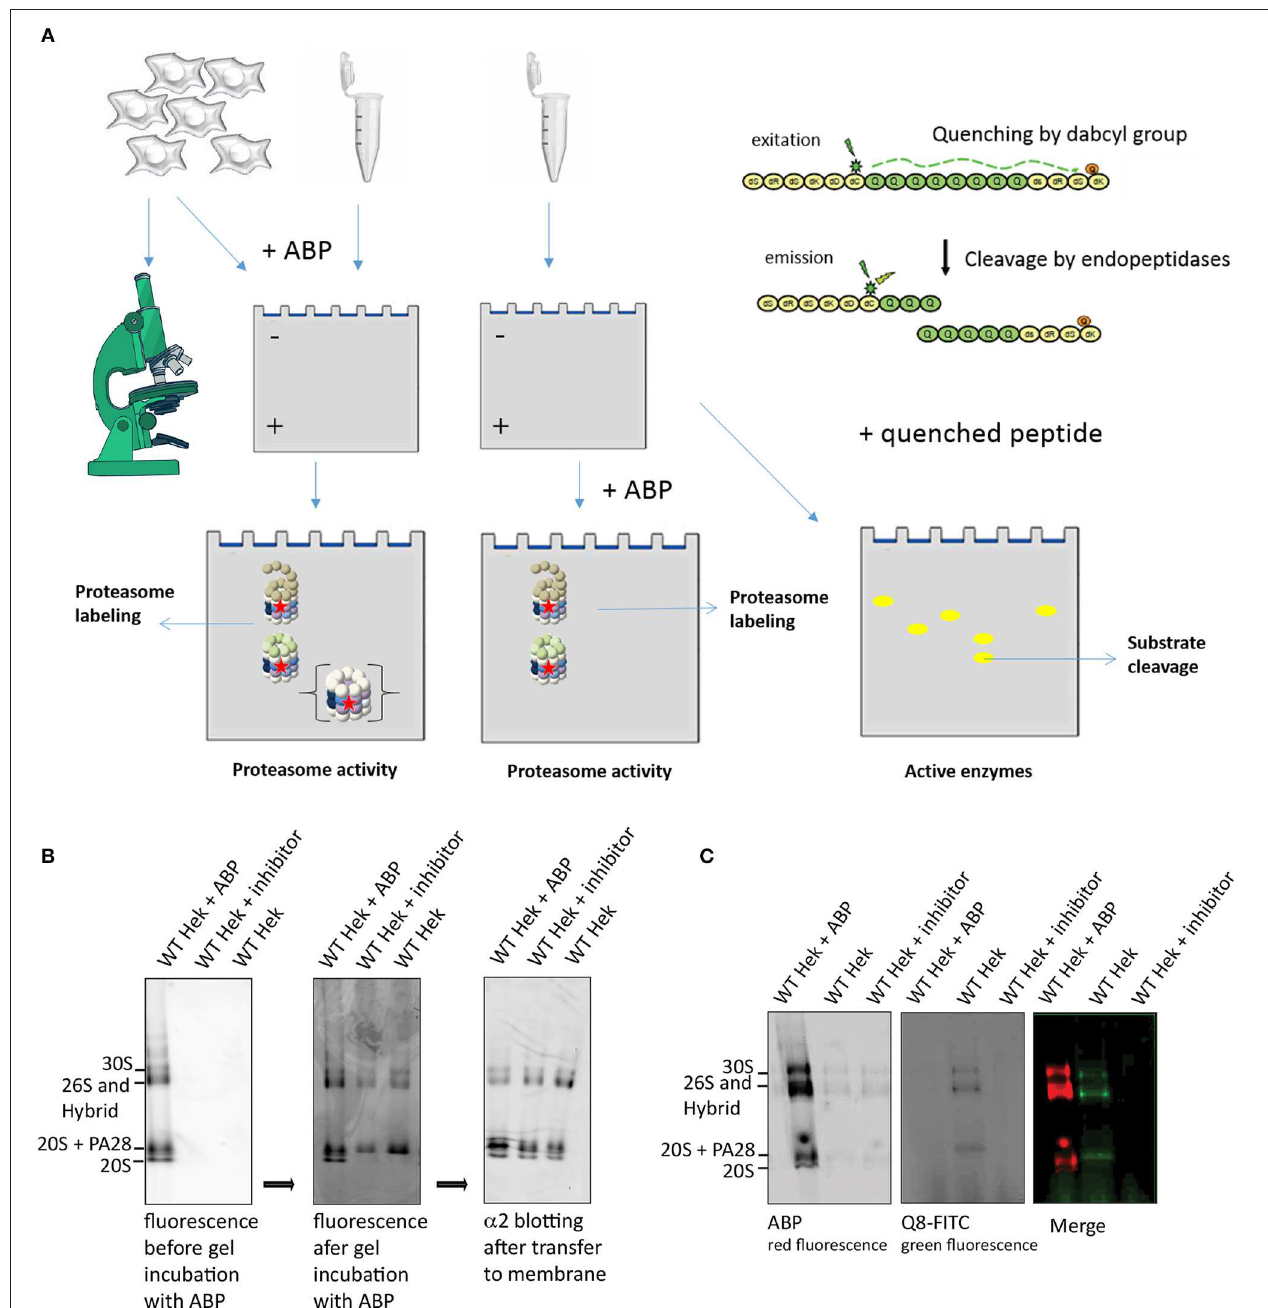
FIGURE 5 | Proteasome activity labeling in gel . (A) A schematic representation of methods to visualize proteasome activity, either by microscopy or by in gel visualization. The left panel represents methods to detect ABP labeling and the right panel explains the use of quenched substrates to determine proteasome specificity. (B) Proteasome labeling in gel. HEK293 cell lysate was divided in three fractions, one fraction was pre-incubated with ABP4 for identification of proteasome complexes, one fraction was pre-incubated with proteasome inhibitor to determine specificity and one sample was left untreated. Upon complex separation by a 3–12% native gradient gel, the wet gel slabs were scanned for fluorescence (left panel). Subsequently, the gel was incubated with buffer containing ABP4 and again scanned for fluorescence (middle panel). After protein transfer to a PVDF membrane, α 2-antibodies confirmed the presence of all proteasome complexes in each lysate. Differences in proteasome labeling were observed between the lysates, since in gel labeling only revealed proteasomes capped with a proteasome activator. (C) Quenched peptide substrates to determine proteasome specificity in gel. HEK293 cell lysates were divided in three fractions, one fraction was pre-incubated with ABP4 for identification of proteasome complexes, one sample was left untreated and one fraction was pre-incubated with proteasome inhibitor to determine specificity of the fluorescent degradation signal. After complex separation in the gel, the gel was incubated in buffer containing quenched polyglutamine peptides (Q8-FITC) that become fluorescent after cleavage. Merging the two images shows a proteasome cleavage pattern of the Q8-peptide.